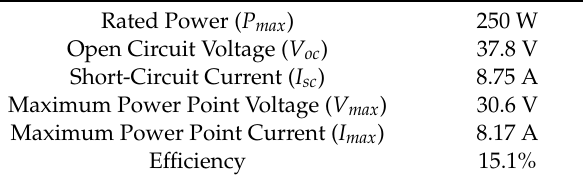
Table 2. ISF-250 model. Performance at an irradiance of 1000 W / m 2 and cell temperature of 25 ◦